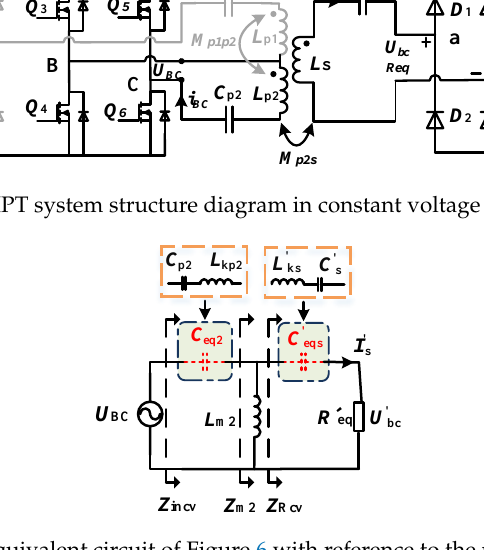
Figure 7. Equivalent circuit of Figure 6 with reference to the primary side.